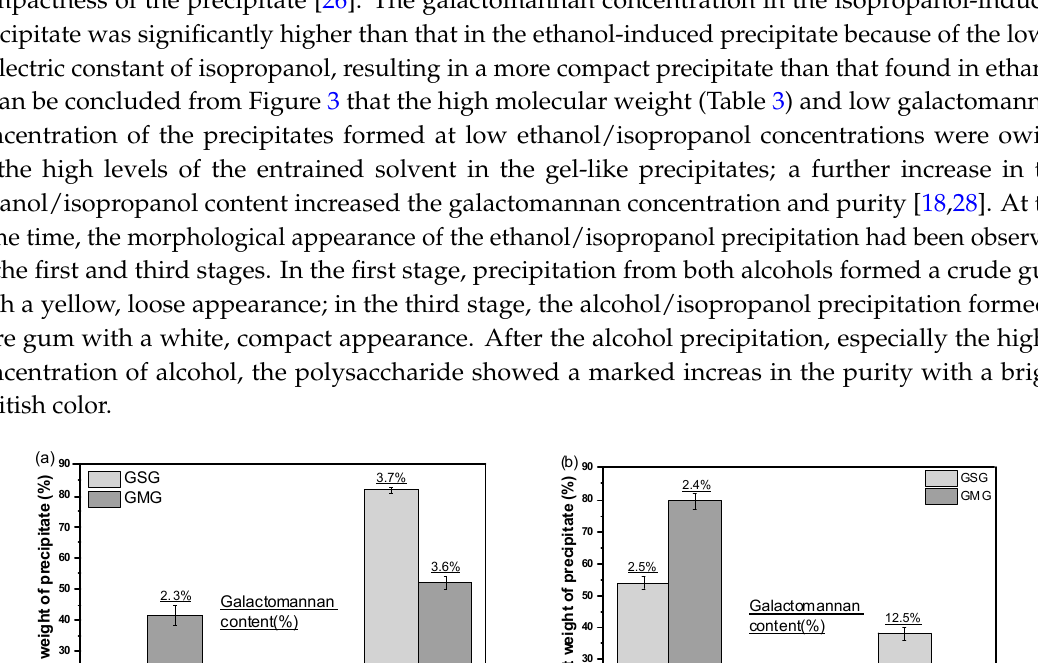
Table 3. The M w M n and M w /M n of GSG and GMG during the ethanol/isopropanol fractional precipitation procedure.